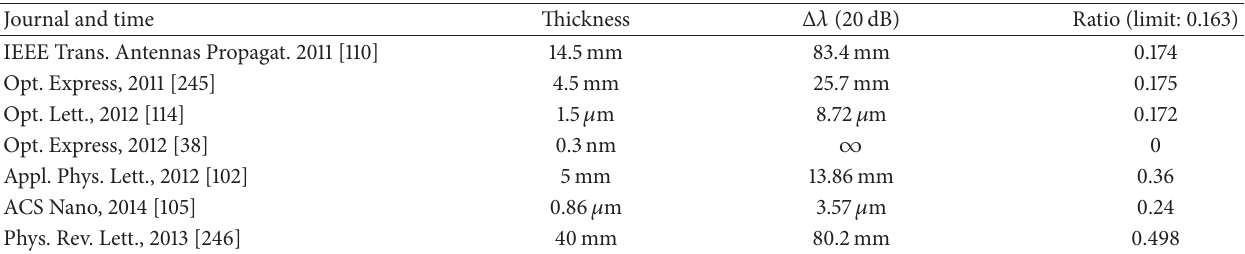
Table 1: Overview of the bandwidth limit for metasurface-based